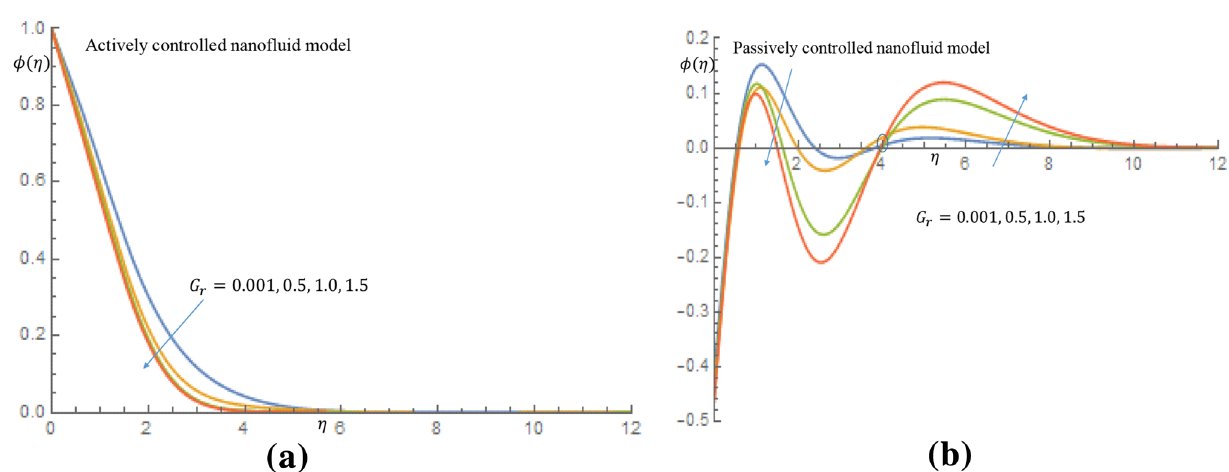
Figure 6. ( a ) Effect of G r on velocity profile when N r = N b = 0.75 . ( b ) Effect of G r on velocity profile when N r = N b = 0.75